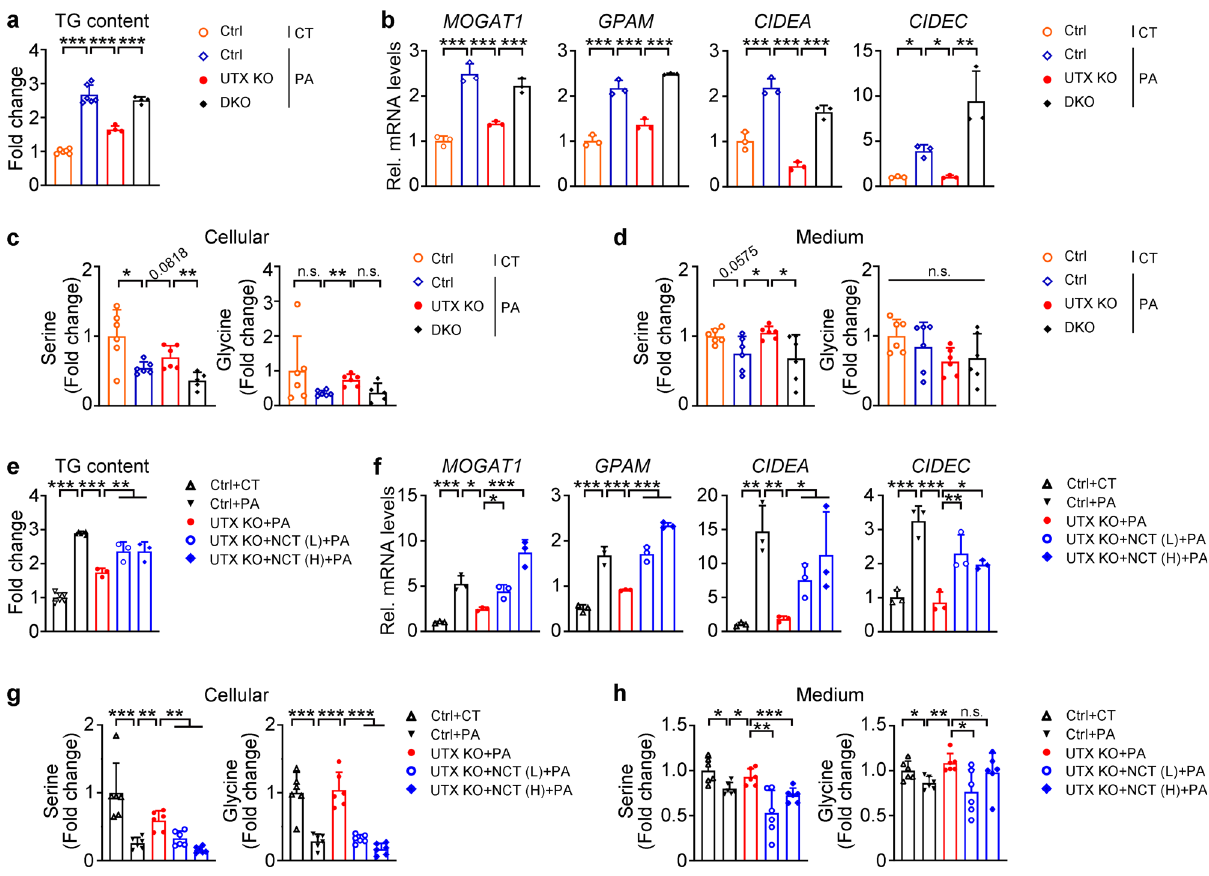
Fig. 7 UTX regulated lipid level through enzymatic activity of PHGDH in cultured renal cells. a , b TG level ( a ) and transcriptional levels of TG synthesis/ lipid storage related genes ( b ) in UTX knockout or UTX/PHGDH double knockout (DKO) HK-2 cells, a n = 6, 6, 4, 4 biological samples for Ctrl + CT or Ctrl + PA or UTX KO + PA or DKO + PA group, respectively (mean±SD); b n = 3 biological samples per group (mean±SD). *** P TG (Ctrl + CT vs Ctrl + PA) <0.0001, *** P TG (Ctrl + PA